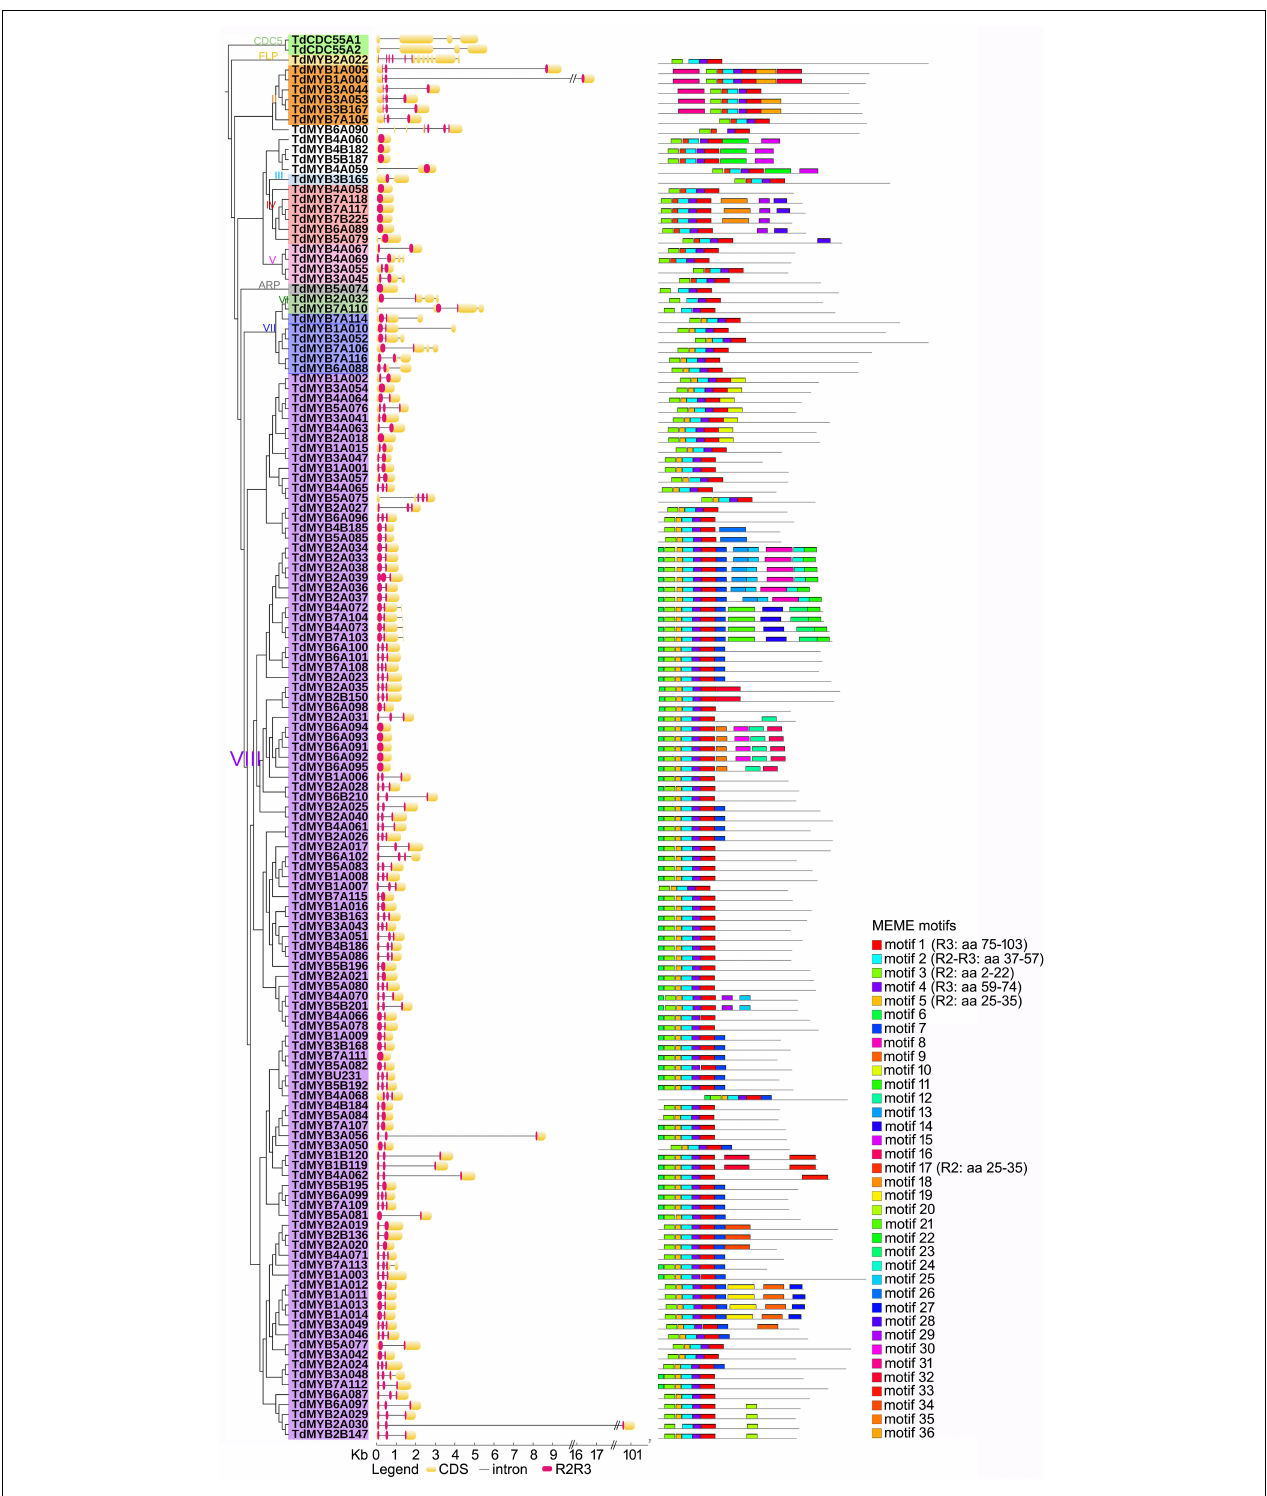
FIGURE 3 | Phylogenetic relationships, gene structure, and motif composition of R2R3-MYBs in durum wheat. To facilitate reading, only one homolog for each couple was considered (141 sequences). In the phylogenetic tree (left), Roman numbers and colors indicate groups according to Jiang and Rao (2020); outgroup: CDC5 genes. In the gene structure (middle), yellow boxes, black lines and red portions designate exons, introns and R2R3 domains, respectively.